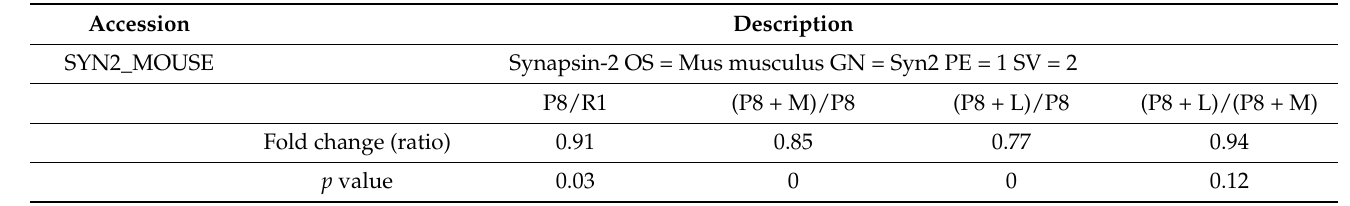
Table 3. Effects of feeding with matcha and decaffeinated matcha on the expression of proteins involved in synapse transmission and nerve cell